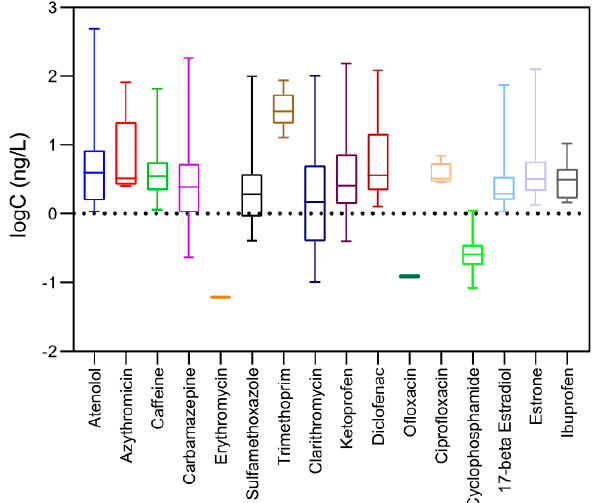
Figure 2. Boxplots showing the differences among the detected concentrations of the sixteen target PhACs in drinking water sources of the Metropolitan Area of Turin (Italy).